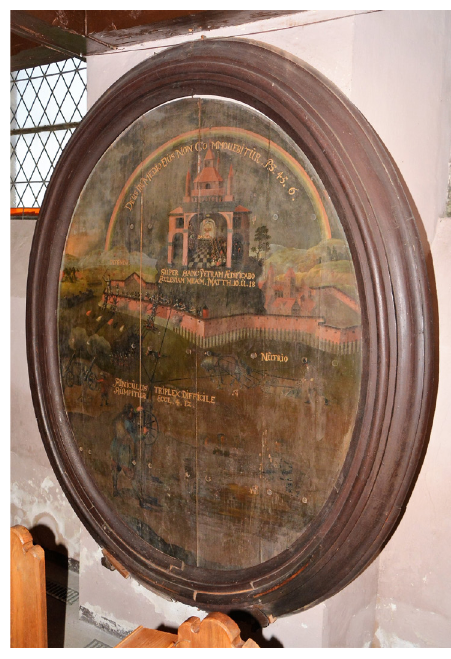
Figure 12 The visual structure of